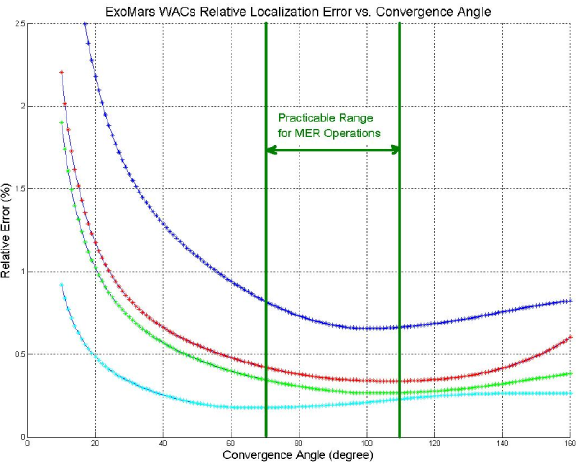
Figure 4. Relative localization error vs. convergence angle.